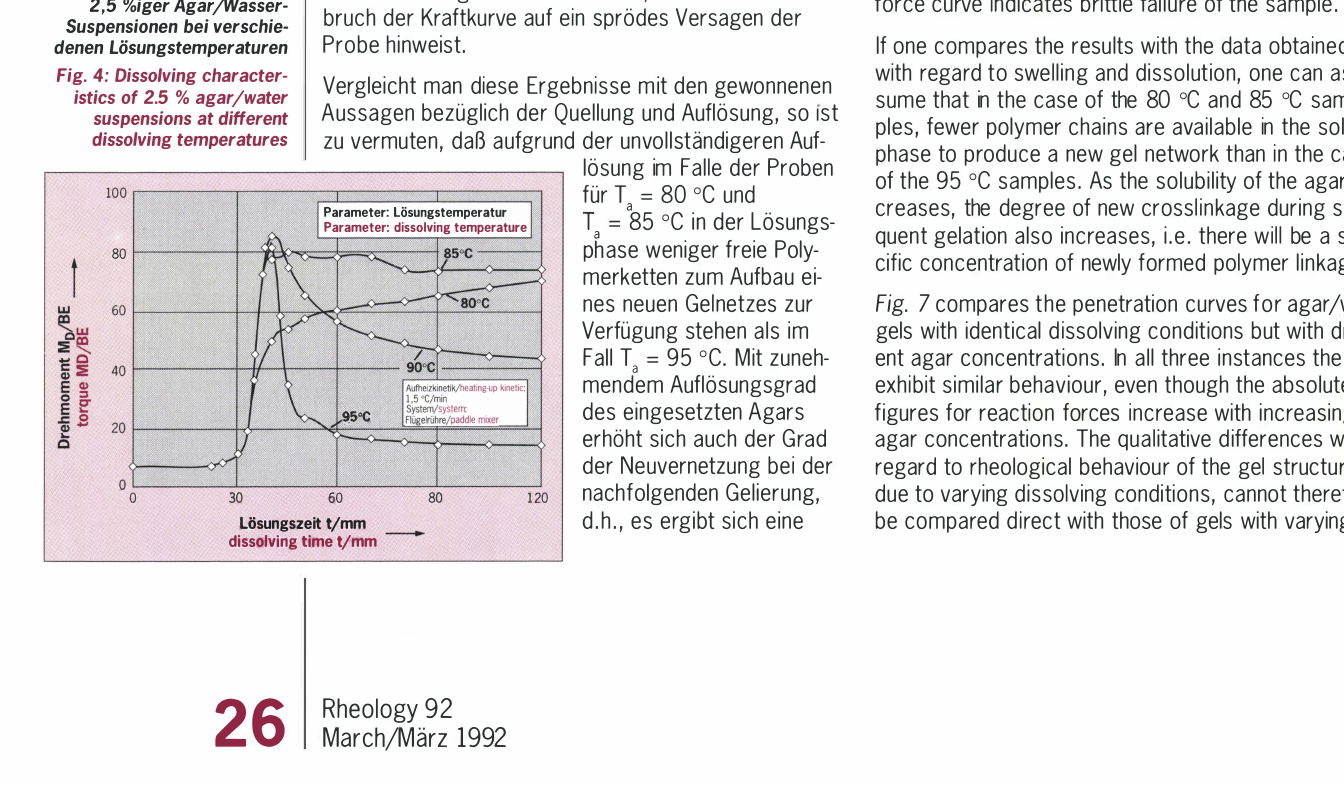
Fig. 4: Dissolving character­ istics of 2.5 % agarjwater suspensions at different dissolving temperatures